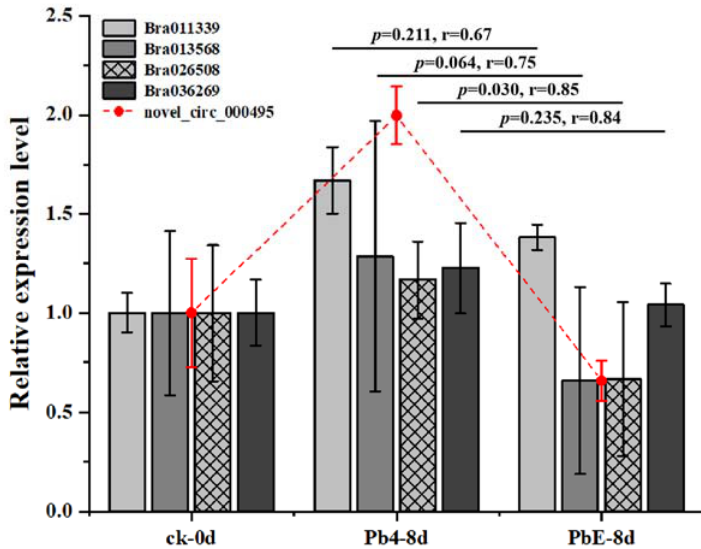
Figure 6. Expression of stress-associated genes at different stages.